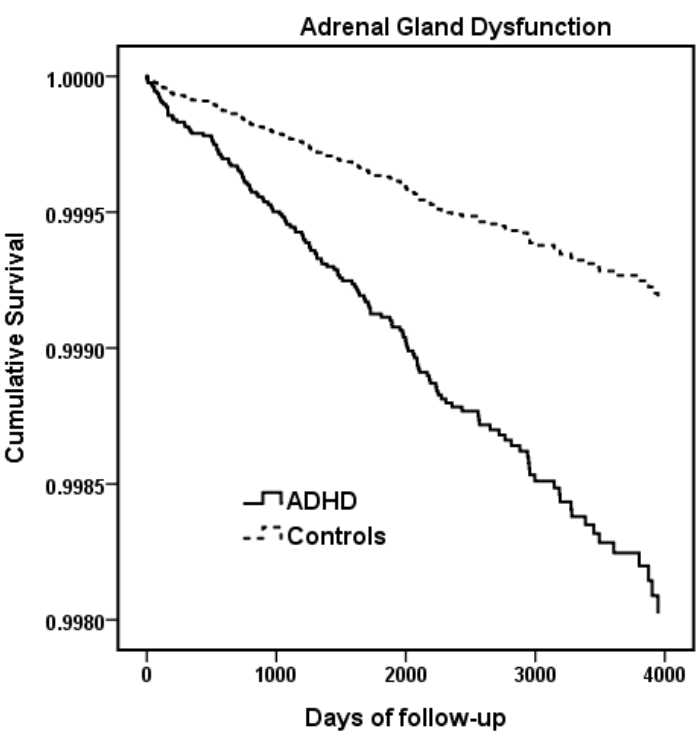
Figure 1. Survival function expressed by Cox regression of adrenal gland disorders among the ADHD and control groups. Table 3. Relationships of pharmacotherapy and diagnoses of adrenal gland dysfunction among patients with ADHD, controlling for sex, age, and psychiatric